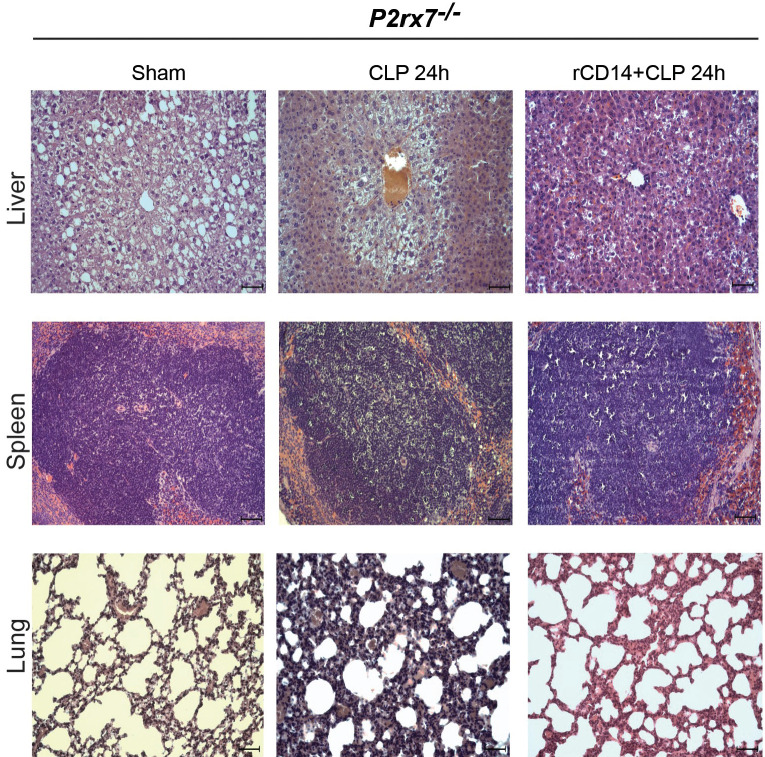
Impact of recombinant CD14 in sepsis.Representative images of hematoxylin and eosin-stained liver, spleen, and lung sections obtained 24 hr after CLP from P2rx7−/− mice treated with recombinant CD14 (rCD14, 100 µg/g) 30 min before CLP. Scale bar 50 μm; images representative of n = 6 independent mice.